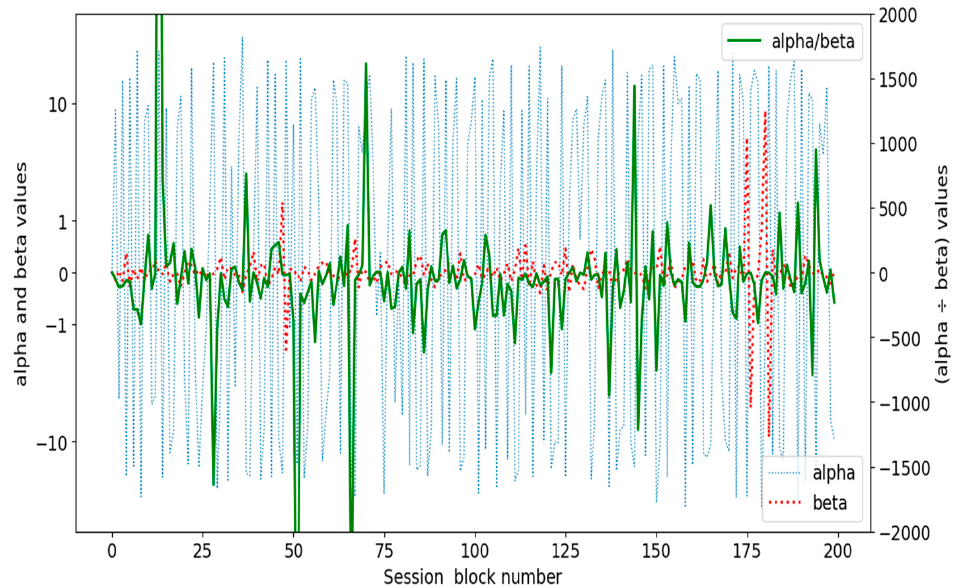
Figure 3. α , β and α / β for 200 blocks of 10,000 sessions (2 million documents retrieved): variation above and under the mean value. α and β correspond, respectively, to the deviations from the average value, within a block of sessions, of the number of readers and the number of